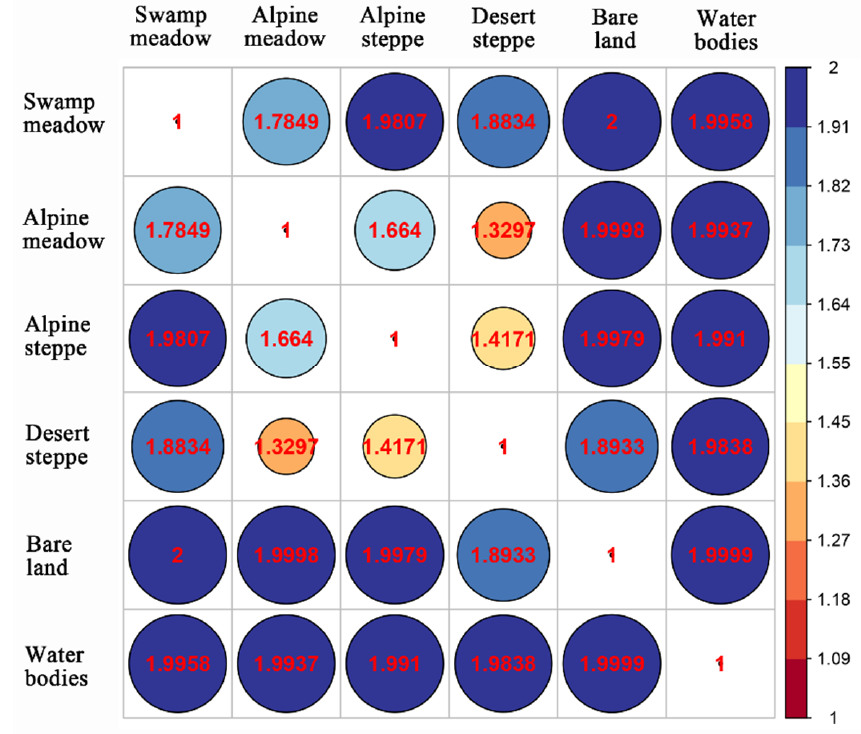
Figure 6. Mean minimum distance matrix (Least to Most) between classified types based on the SVM classifier in Sanjiangyuan Natural Park.